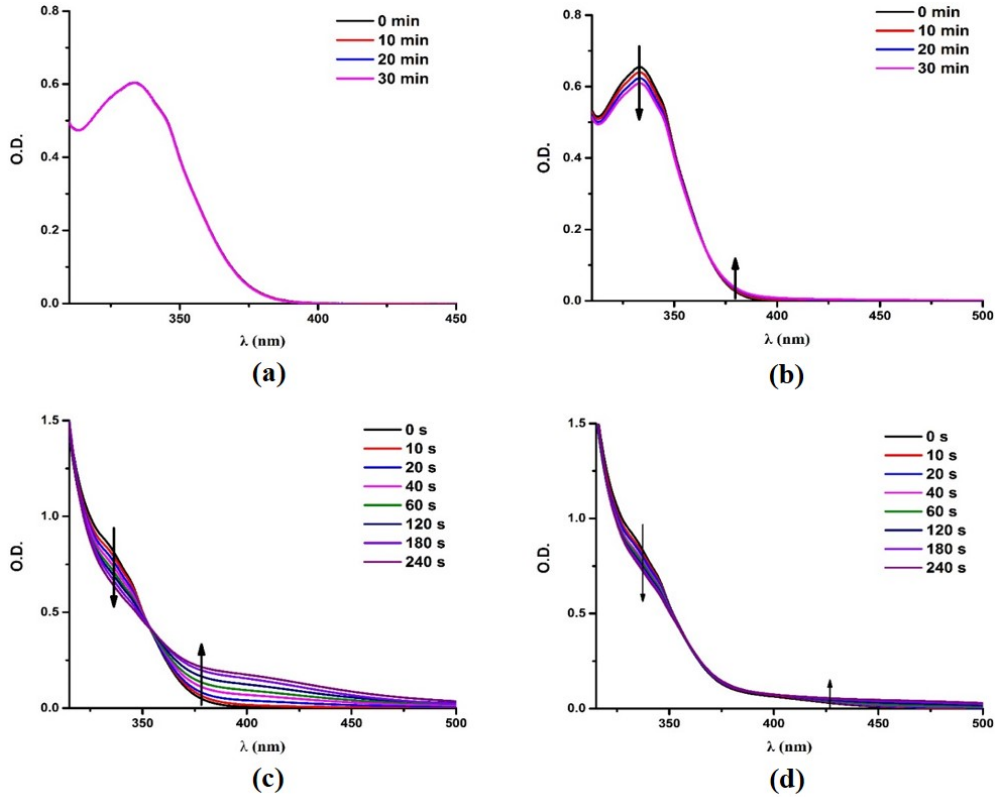
Figure 5. Photolysis of ( a ) BPC1 alone; ( b ) BPC1 / TEOA; ( c ) BPC1 / Iod; ( d ) BPC1 / TEOA / Iod upon LED@375 nm irradiation in acetonitrile ([Iod] = 0.01 M, [TEOA] = 0.01 M).